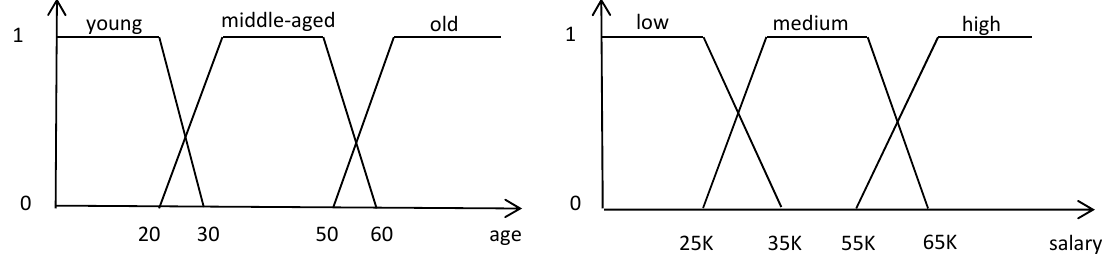
Fig. 8 . Different values of fuzzy age attribute Fig. 9. Different values of fuzzy salary